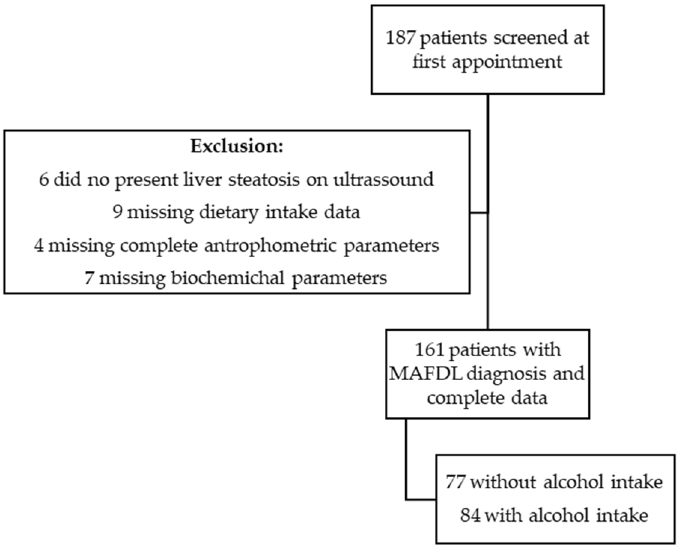
Figure 1. Flowchart of patient’s inclusion.